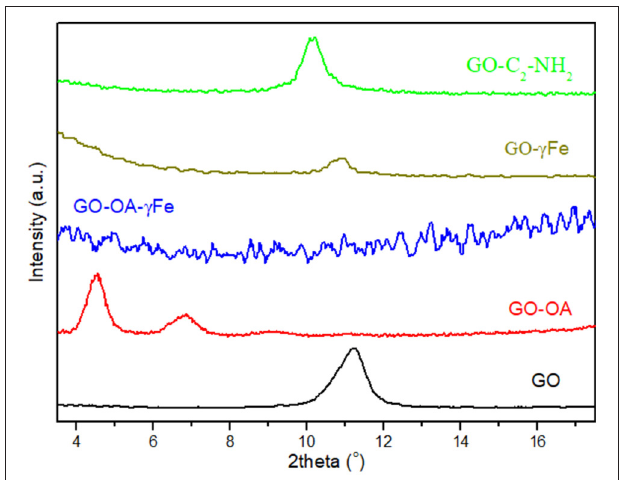
FIGURE 2 | X-Ray diffraction for the nanomaterials GO, GO-OA, GO-OA- γ Fe, GO- γ Fe, and GO-C 2 -NH 2 .